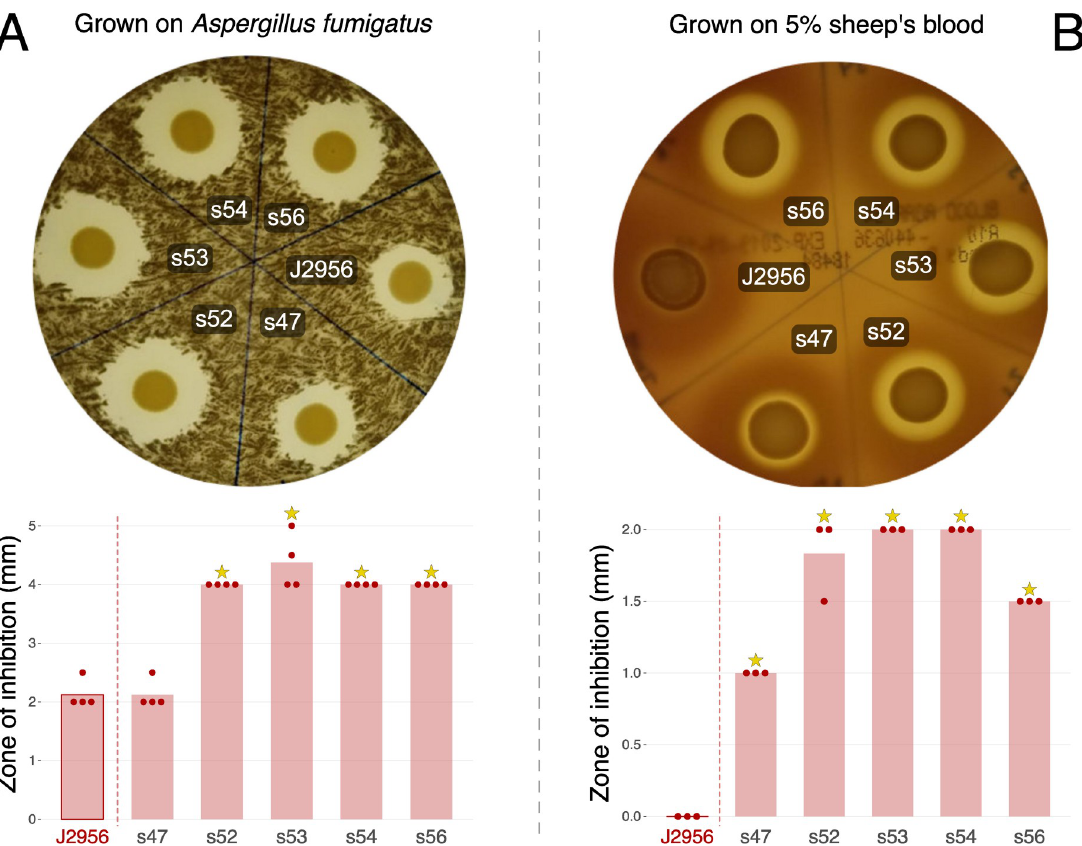
Fig 8. B . contaminans grown on TSB plates with Aspergillus fumigatus and 5% sheep’s blood. (A) Grown with Aspergillus fumigatus , n = 4. (B) Grown with 5% sheep’s blood, n = 3. Plotted are zones of inhibition for each in millimeters; bars represent means, all data points shown as dots. Stars indicate adjusted p-values < = 0.003 following two-sided t-tests compared to the terrestrial reference J2956 (adjusted by Bonferonni correction).